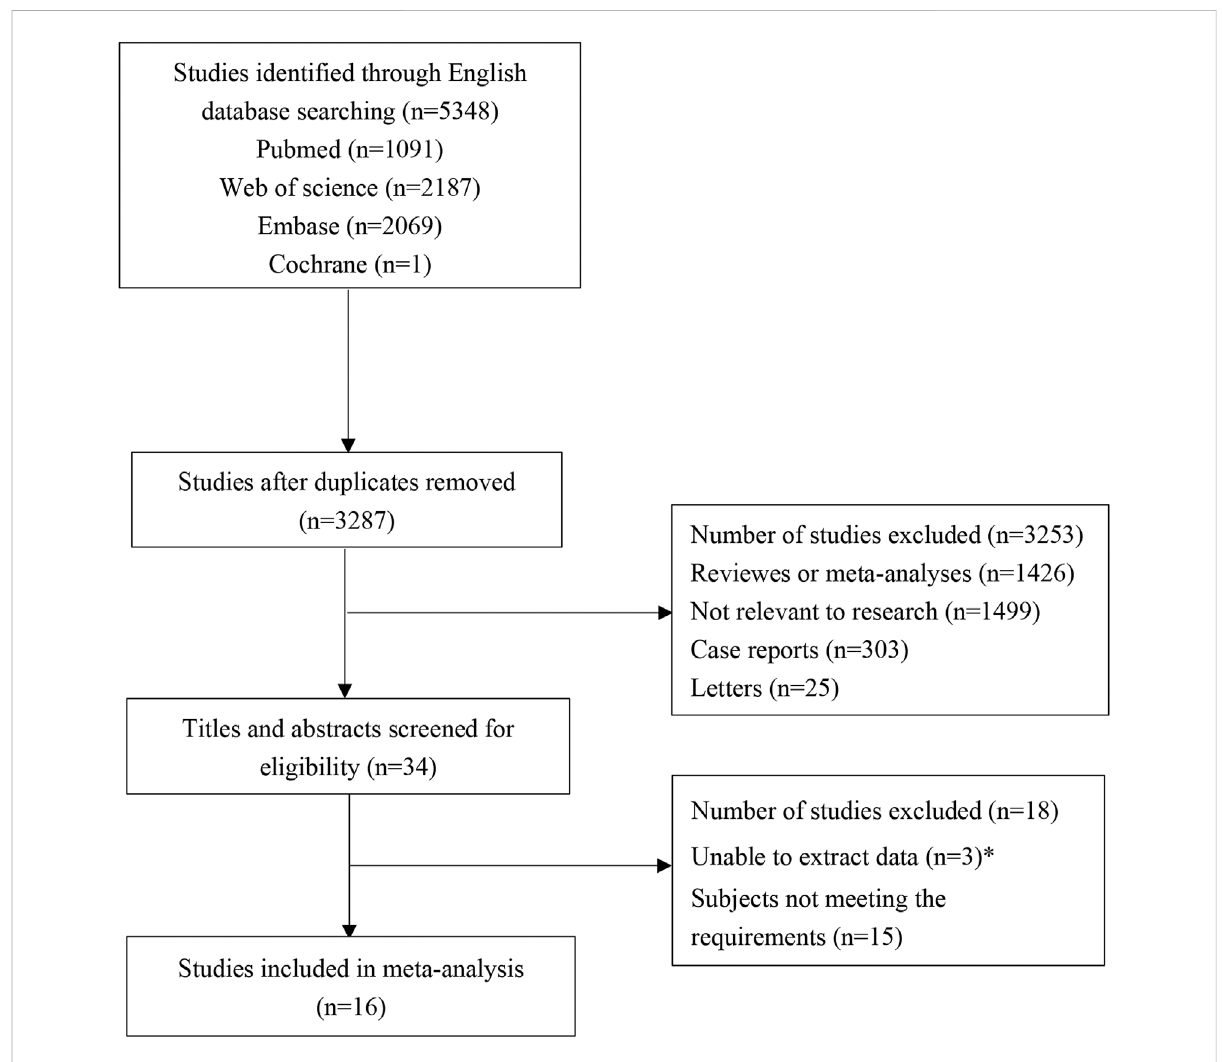
FIGURE 1 Flow chart of study selection and patient ’ s